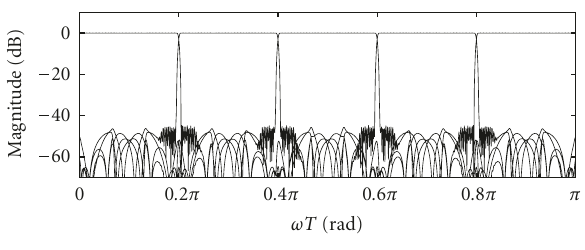
Figure 10: Magnitude responses of the analysis filters with N G = 39 and N F = 58, Example